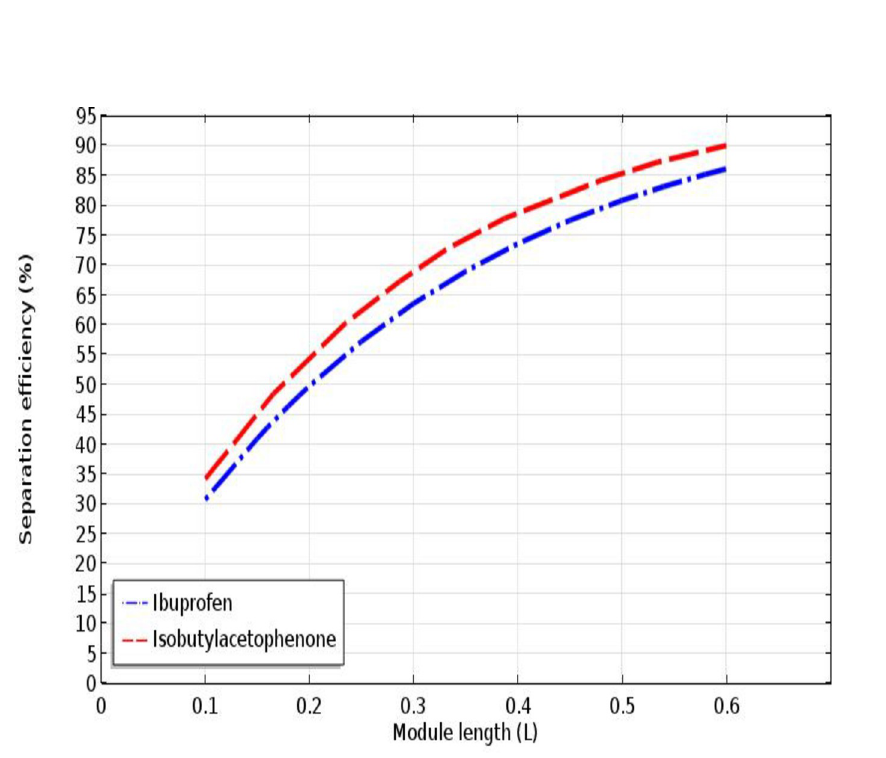
Fig 10. Effect of module length on the IP and 4-IBAP solutes molecular separation.